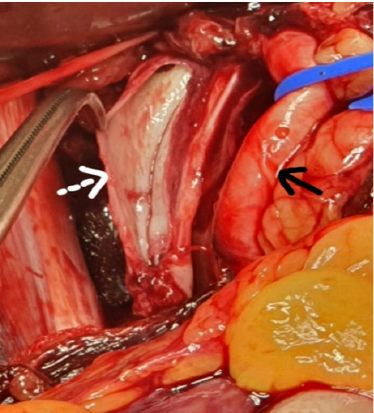
Figure 2. Intraoperative image. Because the patient enters cardio ‐ respiratory arrest, the CT examination is interrupted, resuscitation maneuvers are started, and orotracheal intubation is practiced with a resumption of cardiac activity. The patient is transported directly to the operating room where emergency surgery is performed and a Leriche ‐ Fontain incision is made with penetration into the retroperitoneum on the left side, without opening the peritoneal cavity. We opted for retroperitoneal access that facilitates the rapid identification of the iliac vessels. A large